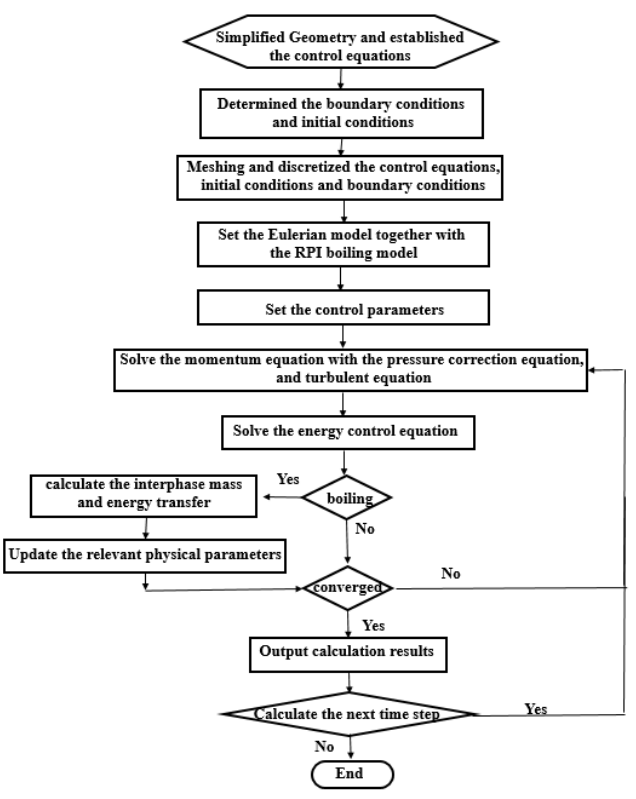
Figure 3. Schematic diagram of enhanced heat transfer performance analysis process.